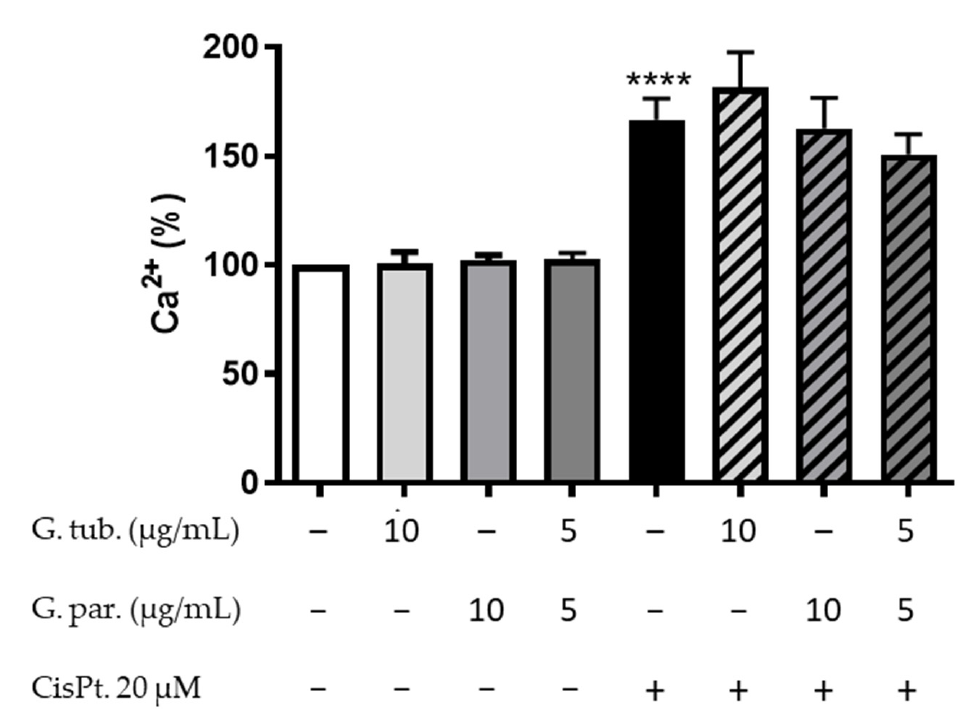
Figure 5. Intracytoplasmic calcium proportion of Fluo-3 AM dyed cells after a 48 h treatment with CisPt 20 µ M and/or the G. tub. extract (10 µ g/mL), the G. par. extract (10 µ g/mL) or the G. tub., and G. par. association extract (each at 5 µ g/mL). Cells were analyzed by flux cytometry, and results are shown as mean of normalized fluorescence compared to controls ± SD of three independent experiments (**** p < 0.0001 compared to the control). The signs + and − indicate the presence or the absence of the corresponding treatment,